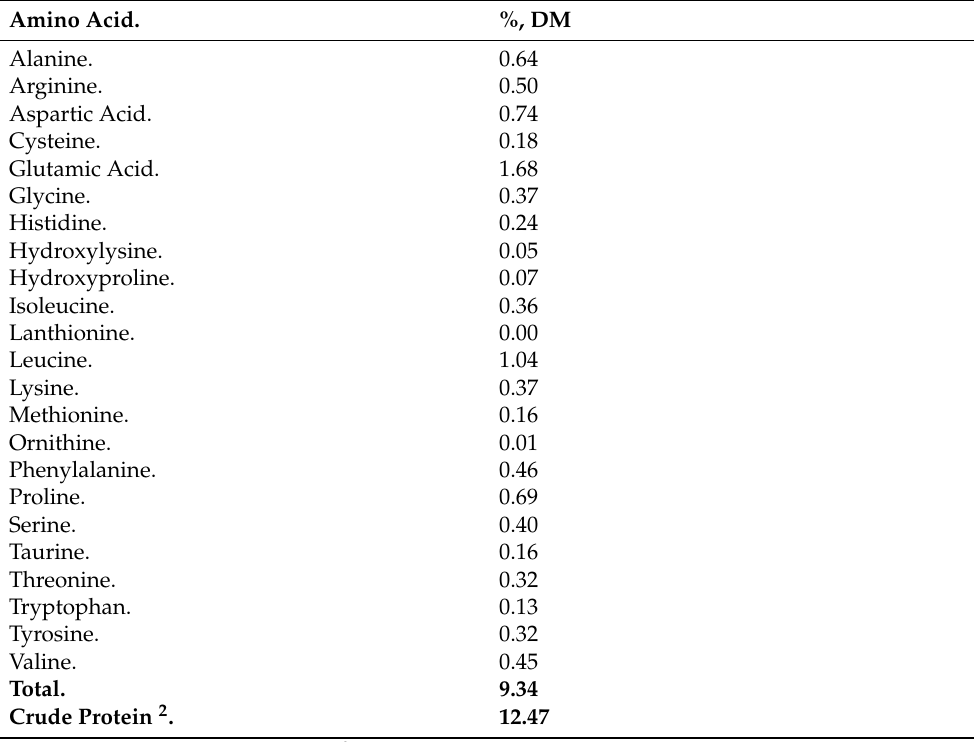
Table 2. Amino acid composition of experimental ration 1